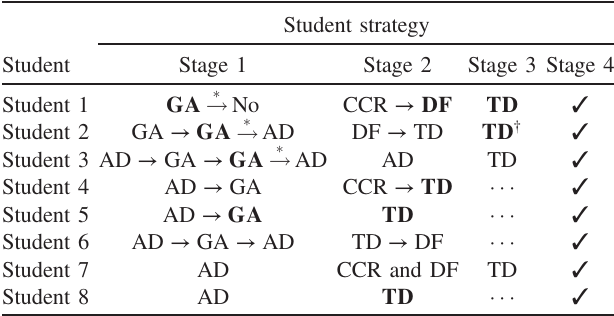
TABLE I. The strategies used by each student to solve the partial derivative problem. Strategies in bold were completed correctly, and arrows indicate when students switched from one strategy to another. GA — graphical analysis approach; AD — analytical deri- vation approach. DF — differentials submethod; TD — tree diagram submethod; CCR — cyclic chain rule submethod. * — interviewer asked, “ how else would you solve the problem? ” or “ is there any alternative way you can solve the problem? ” † — after the inter- viewer asked, “ can U be expressed as the function of only two variables instead of three? ” ✓ — correctly computed the individual partial derivatives from the table and the graph.